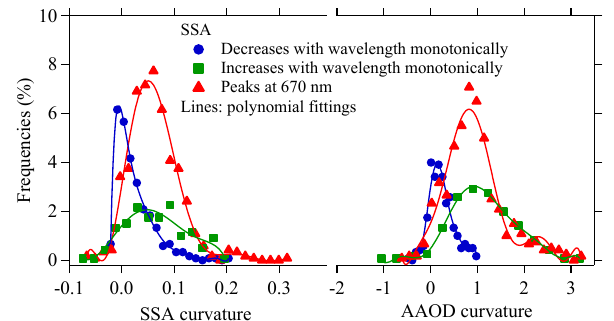
Figure 10. Distribution of the SSA and AAOD curvatures in the ur- ban area of Nanjing under different spectral SSA conditions, includ- ing monotonically decreasing, increasing SSA spectra and peaked SSA spectra.